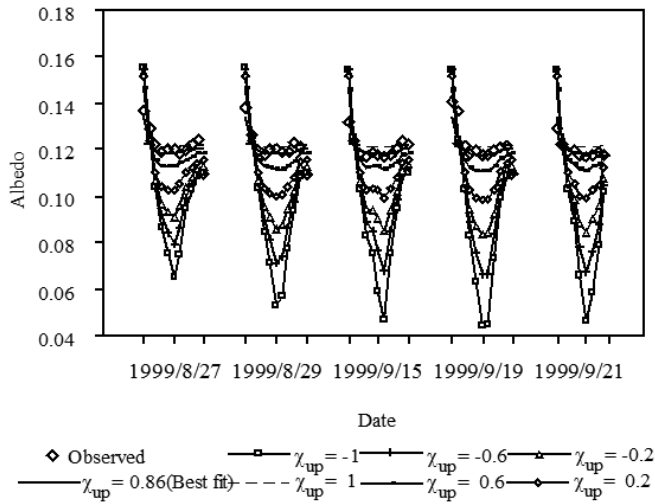
Fig. 5 – Temporal variation of the albedo observed in the Cuieiras Biological Reserve (K34) and the albedo simulated by the IBIS model, according to the upper canopy element orientation